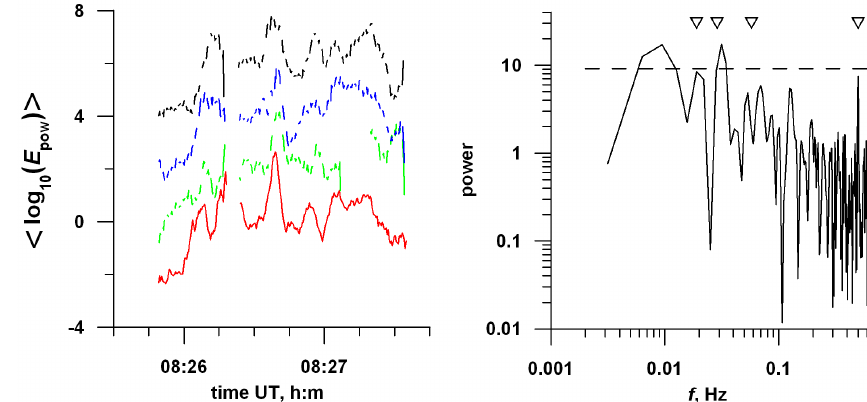
Fig. 4. (a) Profiles for log 10 (E pow ) measured aboard all four Cluster spacecraft upon sliding averaging over 4s time intervals. Measurements were performed by the WHISPER instrument in the Earth’s electron foreshock on 29 March 2001 (event 39). Red, green, blue, and black lines correspond to Sc1, Sc2, Sc3, and Sc4, respectively. To ease the comparison, the curves showing the measurements aboard Sc2, Sc3, and Sc4 are shifted upward by 2, 4, and 6, respectively. (b) Periodogram for wave energy density measured aboard Sc1. The dashed line shows the significance level of 0.05. The triangles have abscissas at 0.33 f Bi , 0.5 f Bi , f Bi , and 0.5Hz. The frequency range of interest is located between the 1st and 3rd triangles, while the last one shows the position of peak resulting from spacecraft spin.